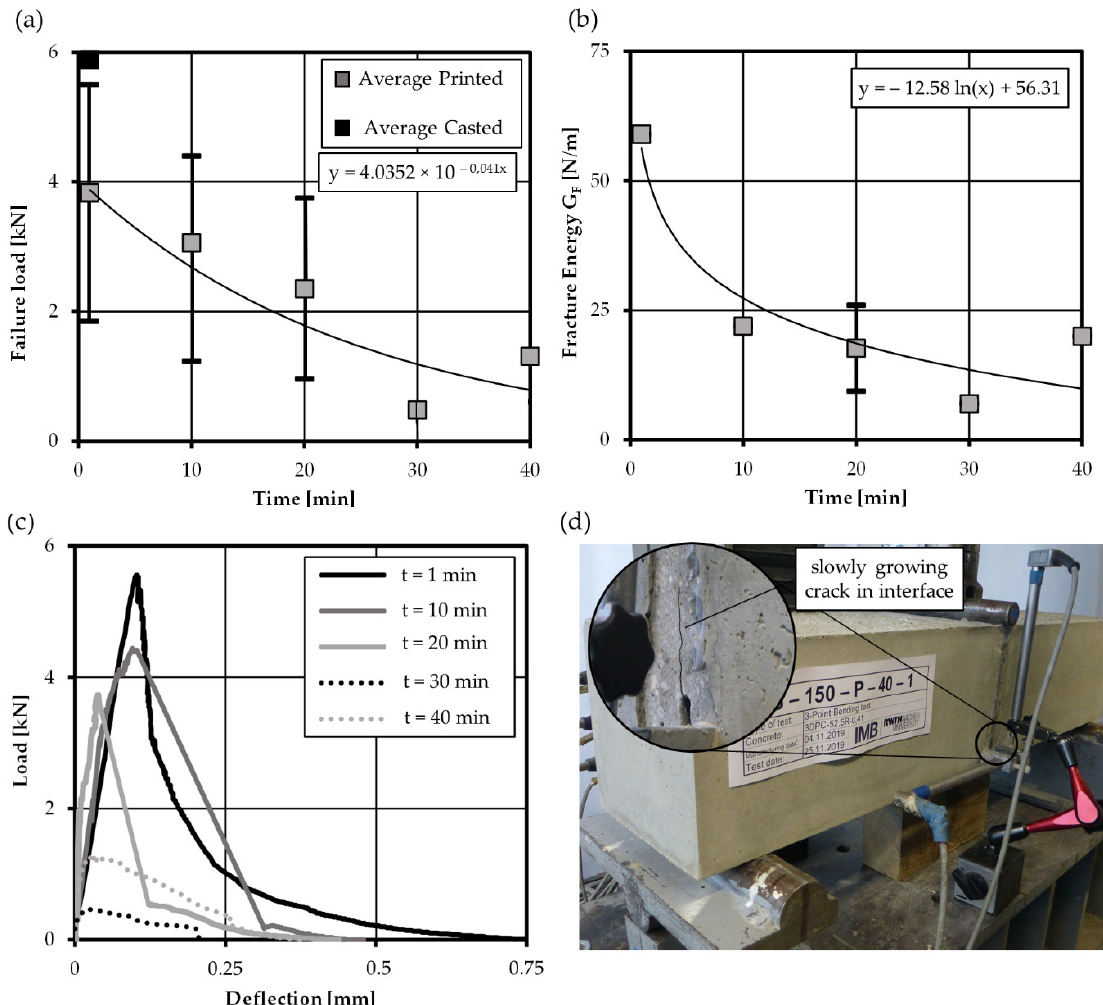
Figure 10. Development of ( a ) fracture load and ( b ) fracture energy over elapsed interval time, ( c ) exemplary load-deflection curves and ( d ) test setup with deflection measurement.